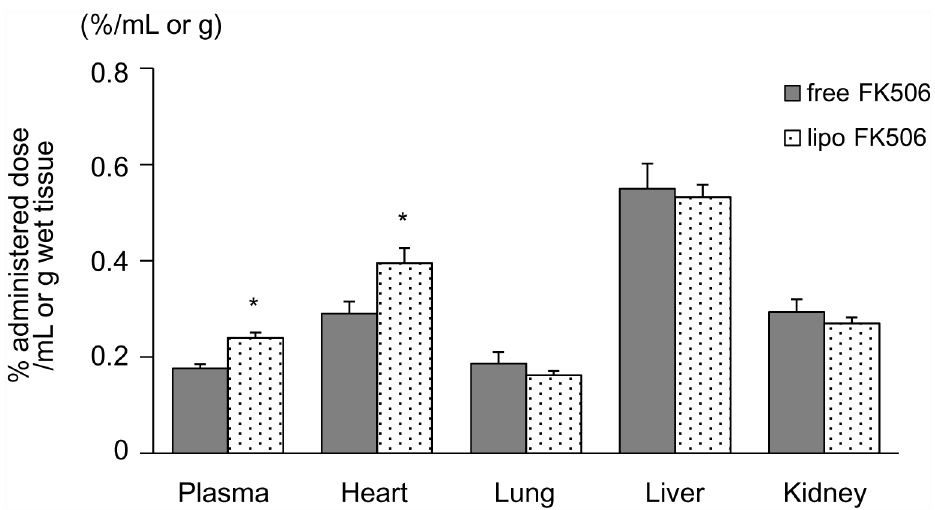
Fig 3. Tissue distribution of free and liposomal FK506 in the rat EAM model. Tissue distributions of [ 3 H]- labeled FK506 in the rat EAM model. Radioisotope activity in tissues was measured 2 hours after the single intravenous administration of free or liposomal [ 3 H]-labeled FK506 on day 17 after immunization (N = 4 in each group). Data are expressed as the mean ± SEM. * P < 0.05 versus the free FK506 treated group.